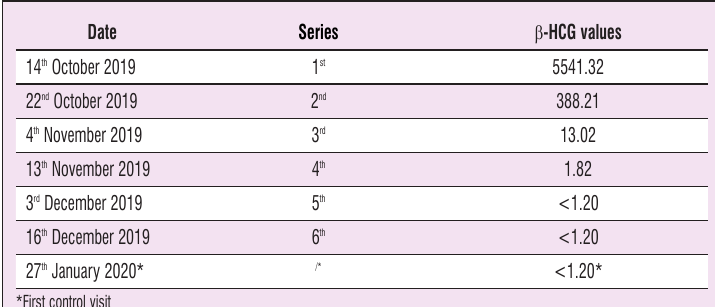
Table 4. β -HCG values during EMA-EP protocol